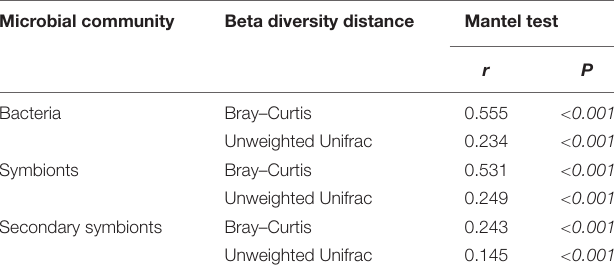
Figure 8 ; P = 0.001). Aphid species (33.4–62.3% of variance) explained more of the overall variance in the data than aphid genus (9.19–32% of variance), geographic region (13– 18.1% of variance) and host plant (12.7–26.9% of variance) in all the